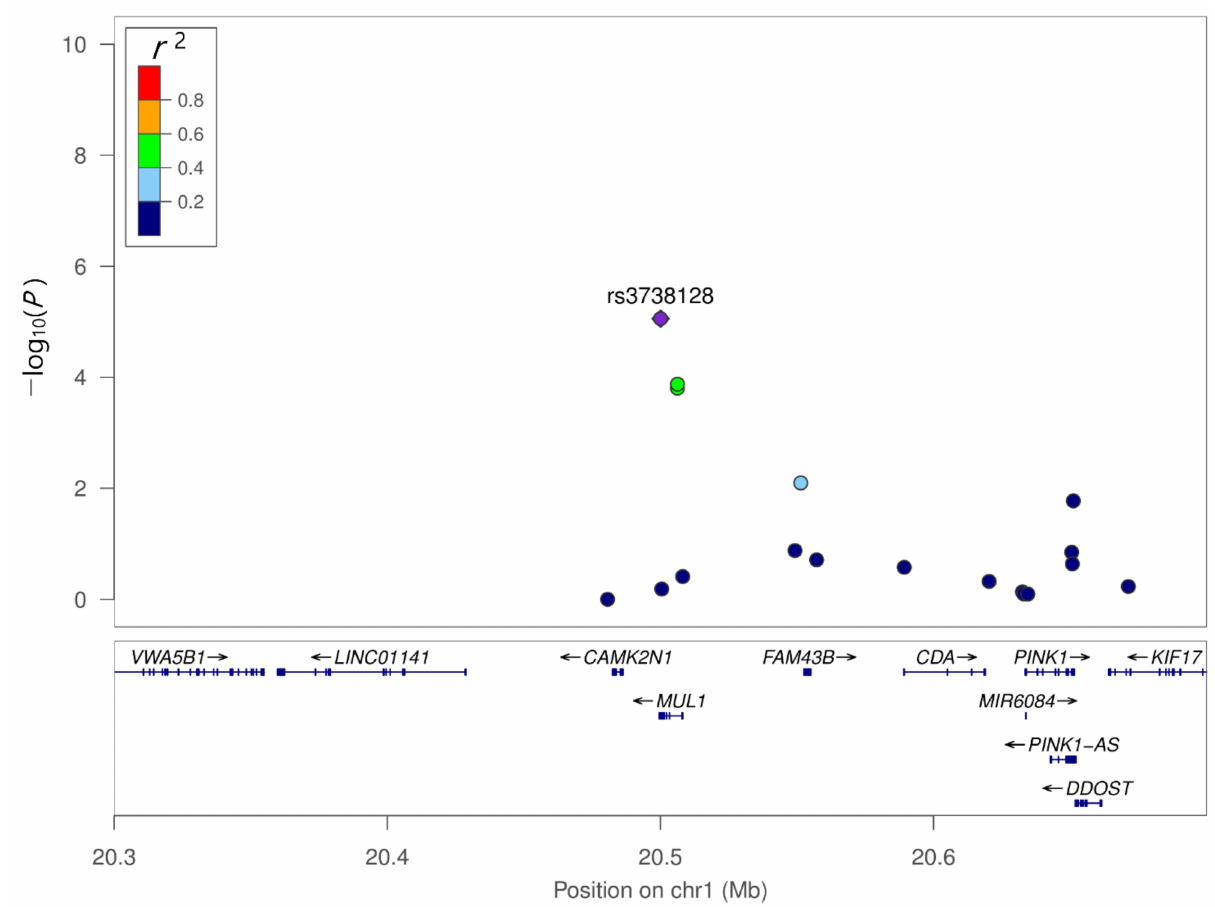
Figure 3. Regional association plot of the genetic variants of MUL1 . MUL1 SNP rs12566937 showed moderate linkage disequilibrium with MUL1 SNP